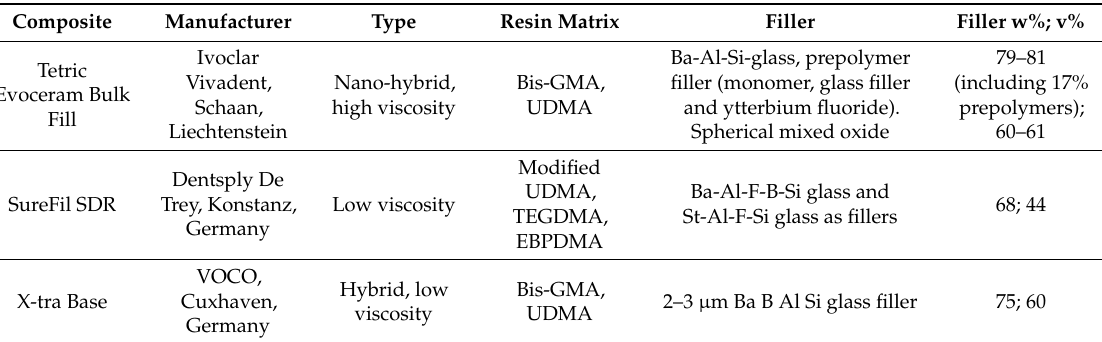
Table 1. Materials